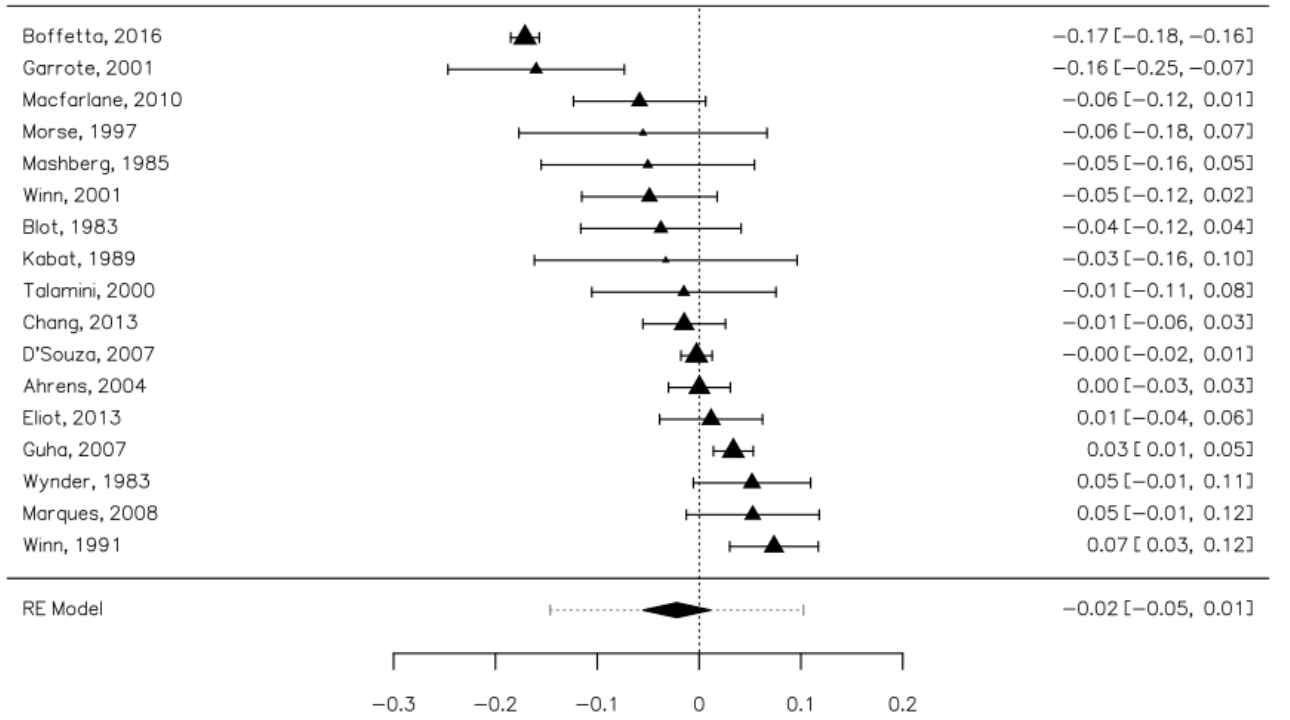
Figure 2. Forrest plot. The overall risk of upper aerodigestive tract cancers associated with mouthwash use.